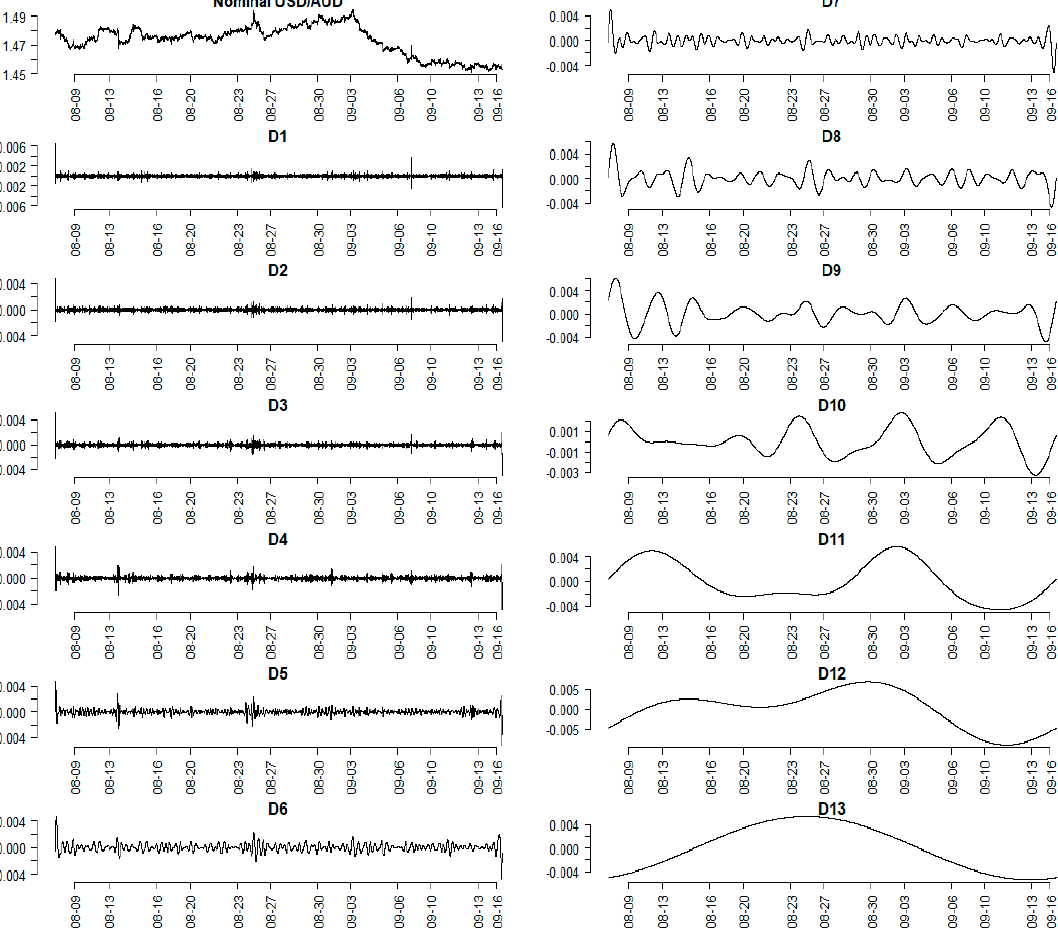
Table 2. Summary statistic of five-minute USD/AUD returns and volatilities.